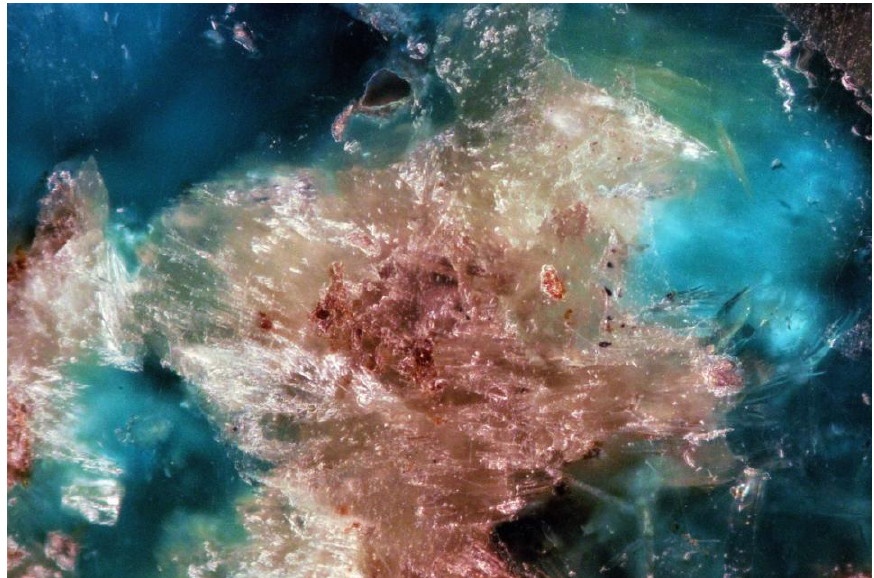
Figure 15. Detail from Se vein Type-4. Dispersed-light dark field image of an acicular aggregate of molybdomenite (colorless transparent) showing internal reflections, partly stained by inclusions of goethite (red-brown,) and surrounded by chalkomenite (blue). Cacheuta is the type locality of chalcomenite and molybdomenite. Width 500 μm.